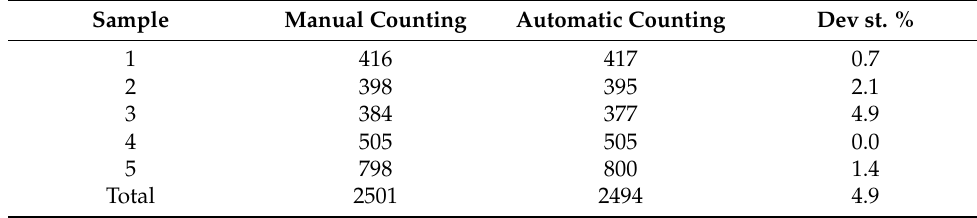
Table 1. Manual vs. automatic counting of